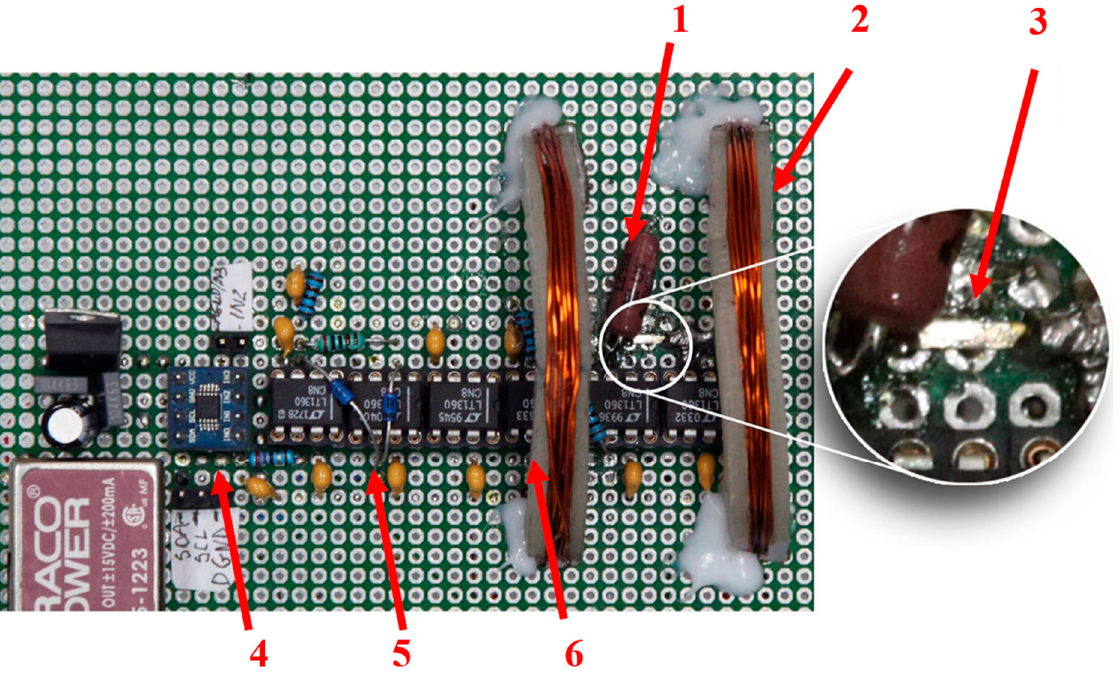
Figure 9. Electronic impedance measurement system. Zoom on the active GMI element: (1) reference resistor; (2) compensation coils; (3) amorphous tape; (4) analog-to-digital converter; (5) peak detector; (6) differential amplifier.